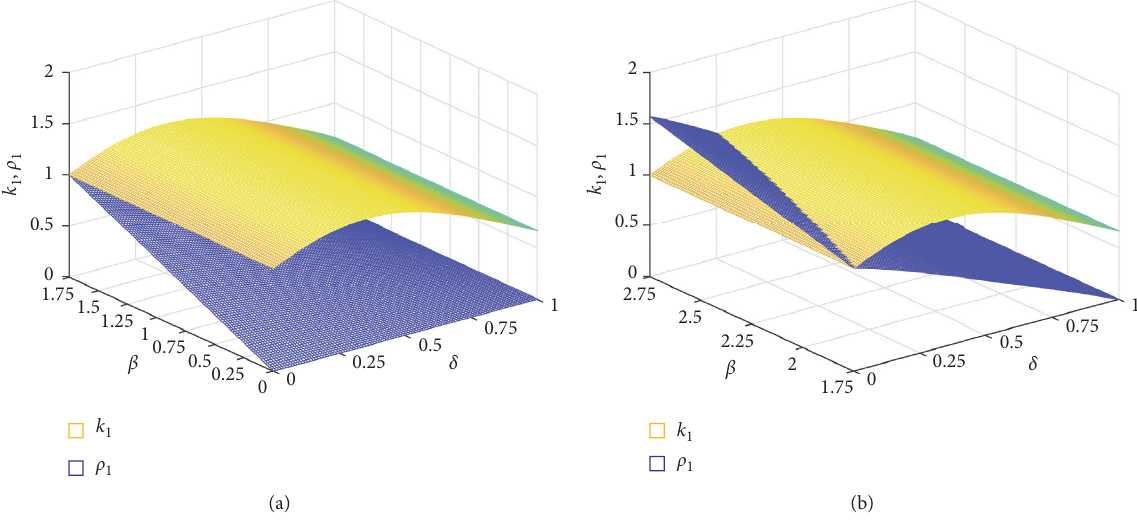
Figure 12: Comparison between thresholds k